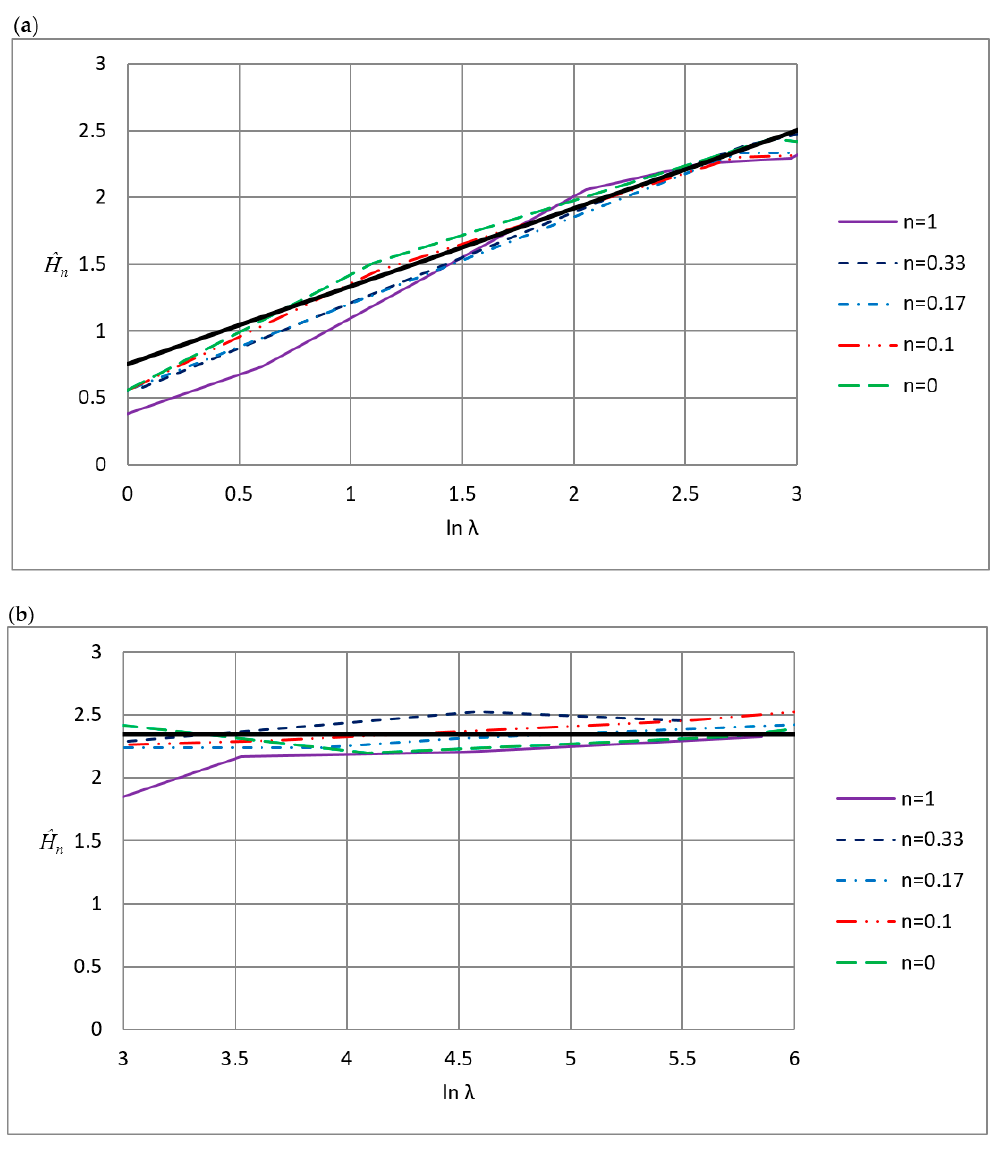
Figure 3. Normalized normal scratch hardness, ˆH n = H n / σ rep , as a function of ln Λ where Λ is the Johnson parameter defined in Equation (1). The results were taken from Larsson [23]. ( a ) The representative stress was determined from σ rep = σ ( ε p = 0.25). The thick line represents upper Equation (8). ( b ) The representative stress was determined from σ rep = σ ( ε p = 0.39). The thick line represents lower Equation